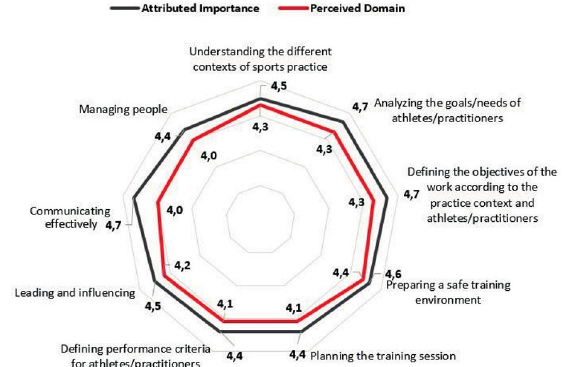
Figure 3. Attributed importance and perceived domain about the competences of racket sports coaches (part